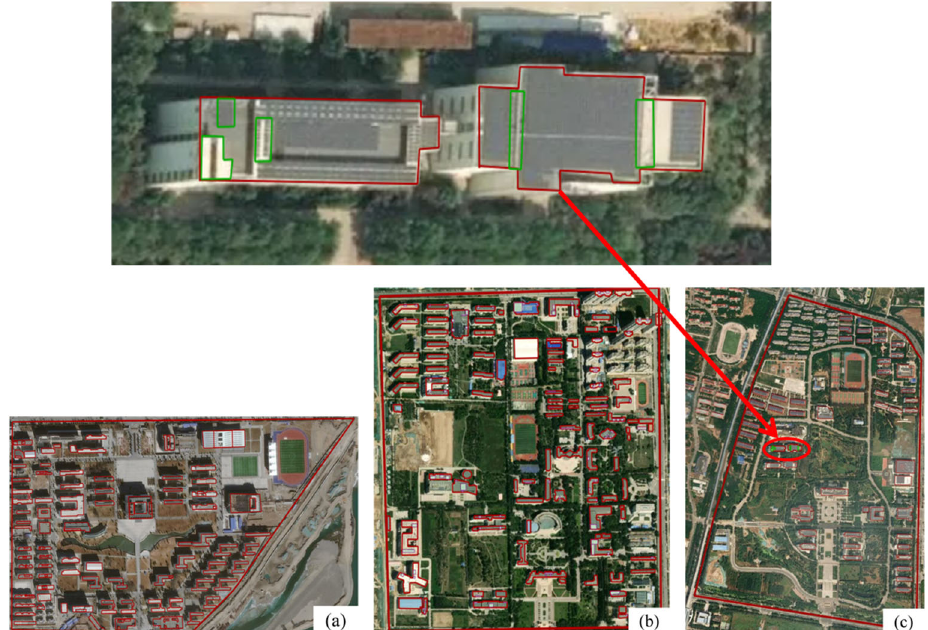
Figure 7. Satellite images and area identification of studied cases via manual screening by LocaSpace Viewer: ( a ) Tibet University; ( b ) Qinghai University; ( c ) Qilu University of Technology.